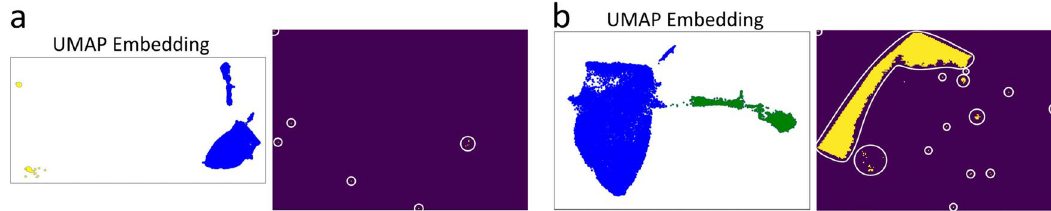
O Figure 2. Interactive artifact and matrix subtraction in data set I v (mouse vibrissae section measured with MALDI-Orbitrap). ( a ) The UMAP embedding with clusters from sample and matrix signals (blue) and selected artifact clusters (yellow) are shown on the left. The corresponding artifact pixel positions are shown on the right and highlighted with white circles. ( b ) The UMAP embedding after removing artifacts. The sample cluster (blue) and the selected matrix cluster (green) are shown on the left. The corresponding matrix pixel positions are shown on the right and are highlighted with circles. The shown visualization is part of ProViMs interactive artifact and matrix subtraction module. The dimension reduction was computed by a successive combination of tSVD 11–13 and UMAP 14,15 as described in “Material and methods”.